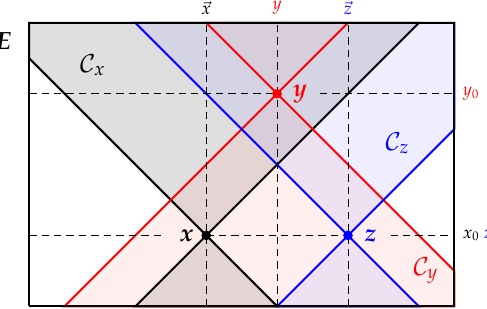
Figure 20. Symmetric double causal cones. Note that ∆ ( x , y ) < ∞ and ∆ ( y , z ) < ∞ , nonetheless ∆ ( x , z ) = ∞ because x = z ∧ (cid:126) x (cid:54) = (cid:126) z = ⇒ x / ∈ C z 0 0